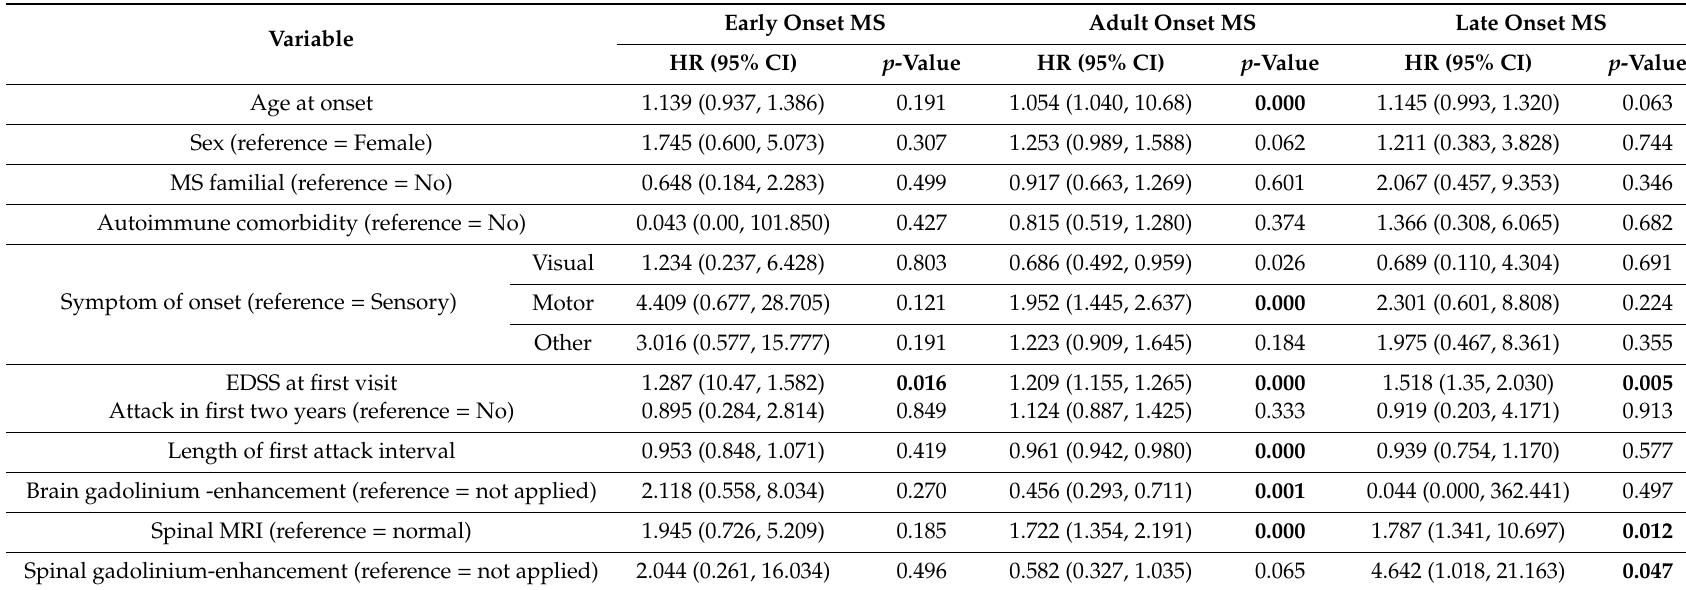
Table 4. Univariate cox regression of variables association with time to conversion to the state of secondary progressive MS